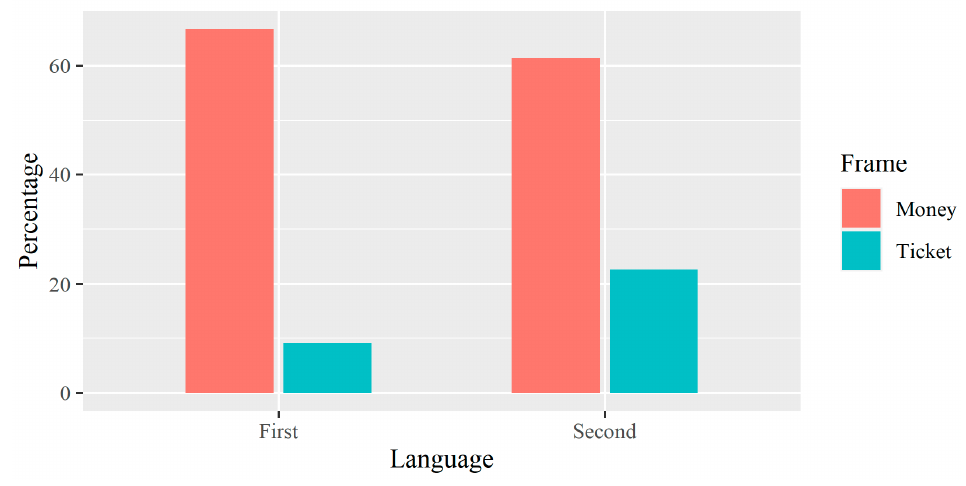
Figure 3. “Yes” responses in money/ticket task.